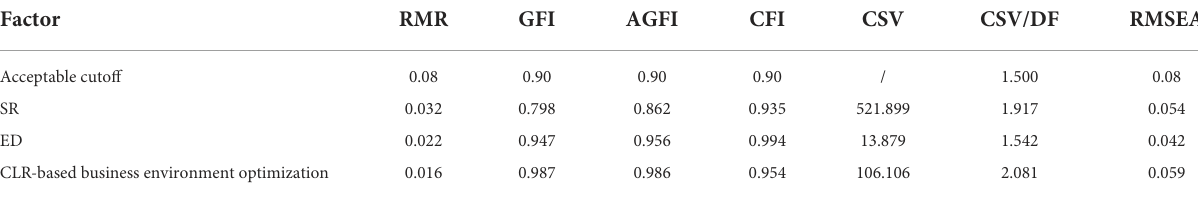
TABLE 1 Model fitting index.